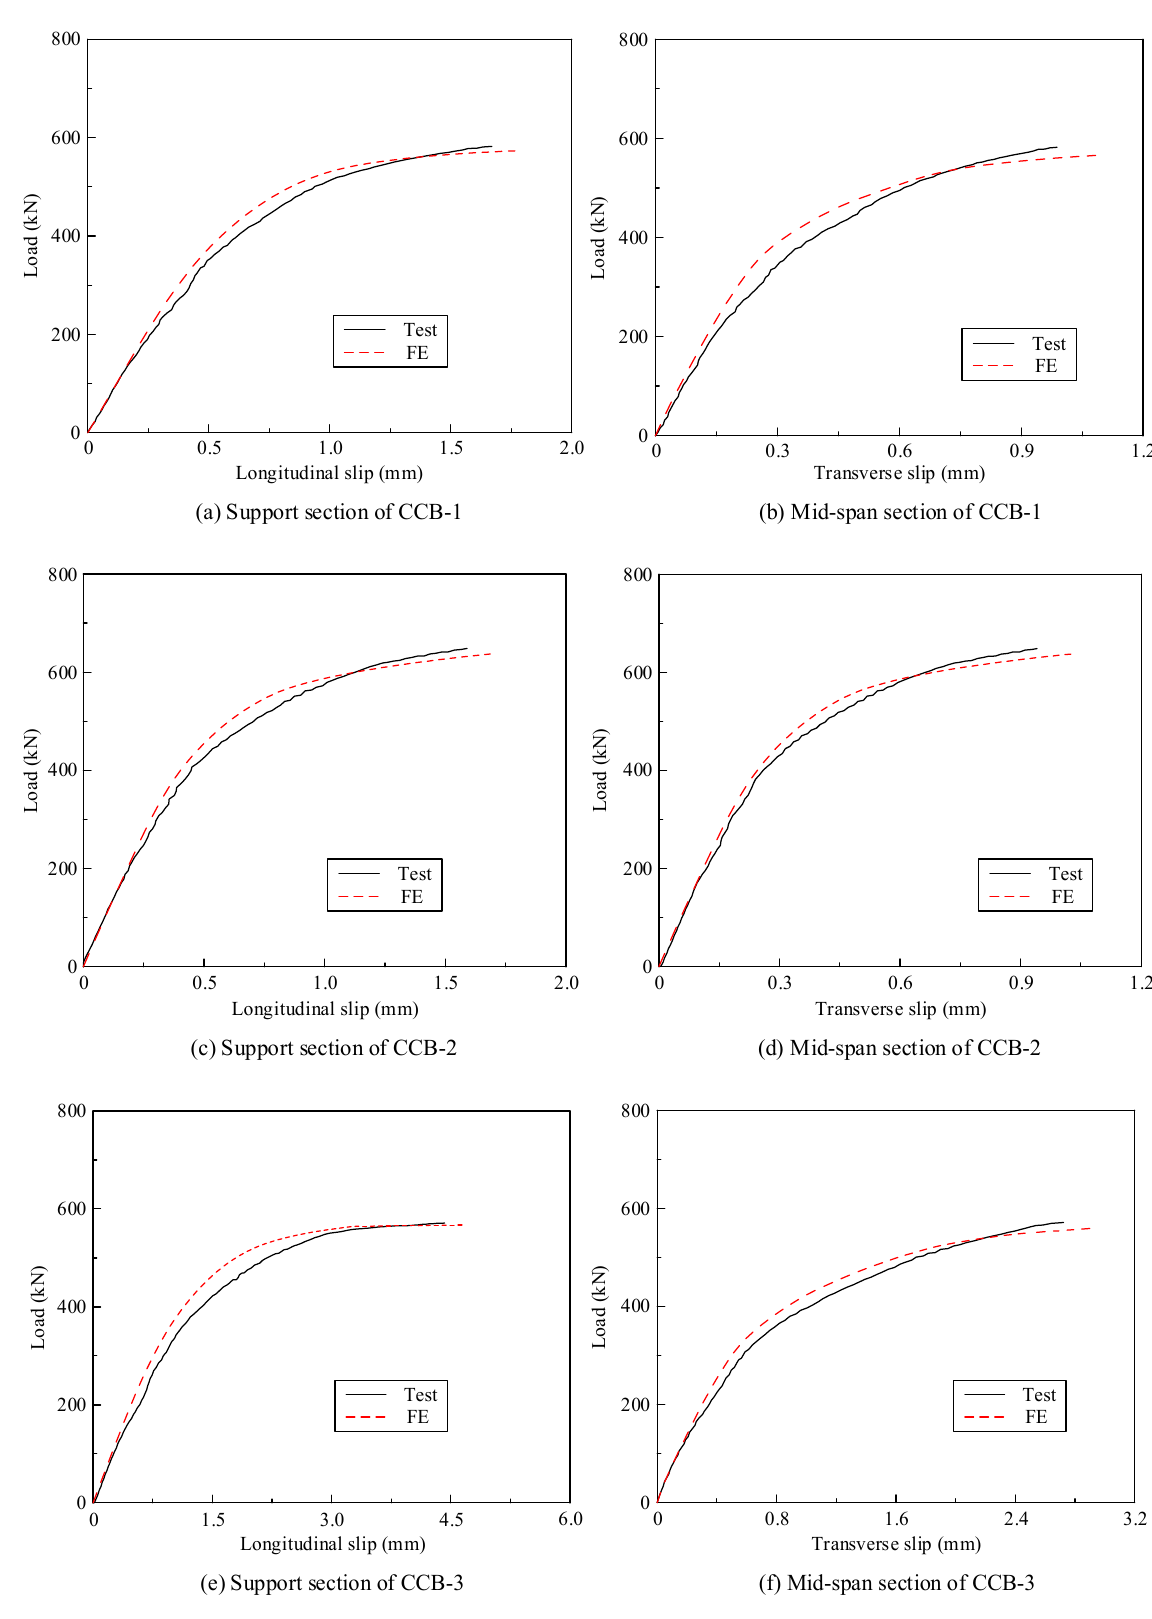
Figure 19. Comparison of the load–interface slip curves from the test and numerical analyses. Figure 20 shows a comparison between the test results and the finite element calcu- lation results of the normal strain of the concrete slabs of the midspan sections and 1/4-